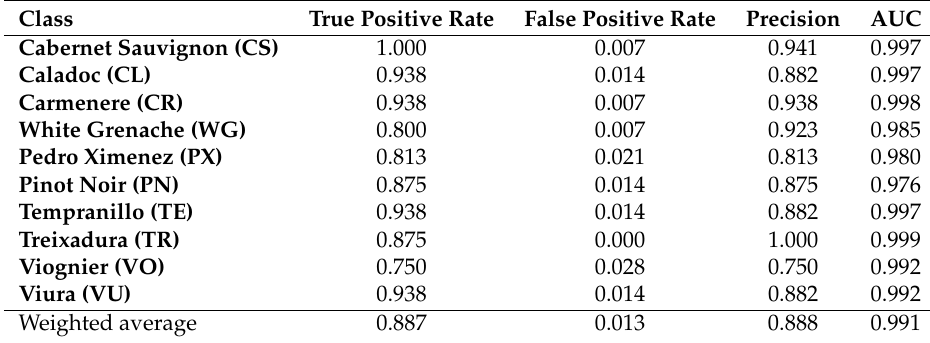
Table 2. Detailed accuracy by class of the grapevine varietal classification using support vector machines and a 5-fold cross-validation (n =